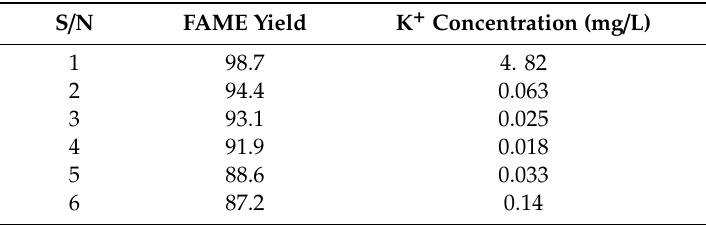
Figure 11. Reusability study of synthesized catalyst at optimized reaction condition (catalyst dosage 15 wt%, methanol to oil molar ratio 12:1, 60 ◦ C reaction temperature and 1 wt% catalyst amount). Table 3. Concentration of leached K + (mg/L) in different reusability samples by Atomic Absorption Spectroscopy (AAS).